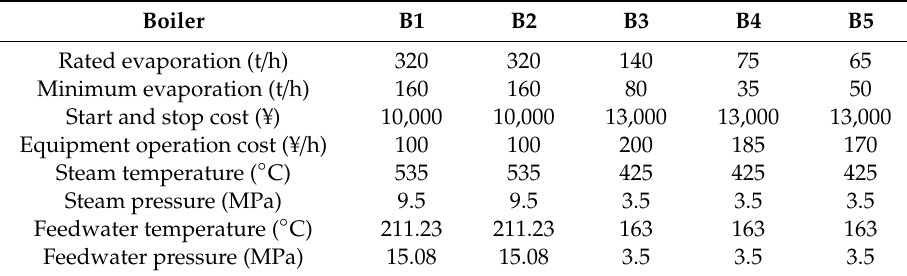
Table 3. Boiler equipment